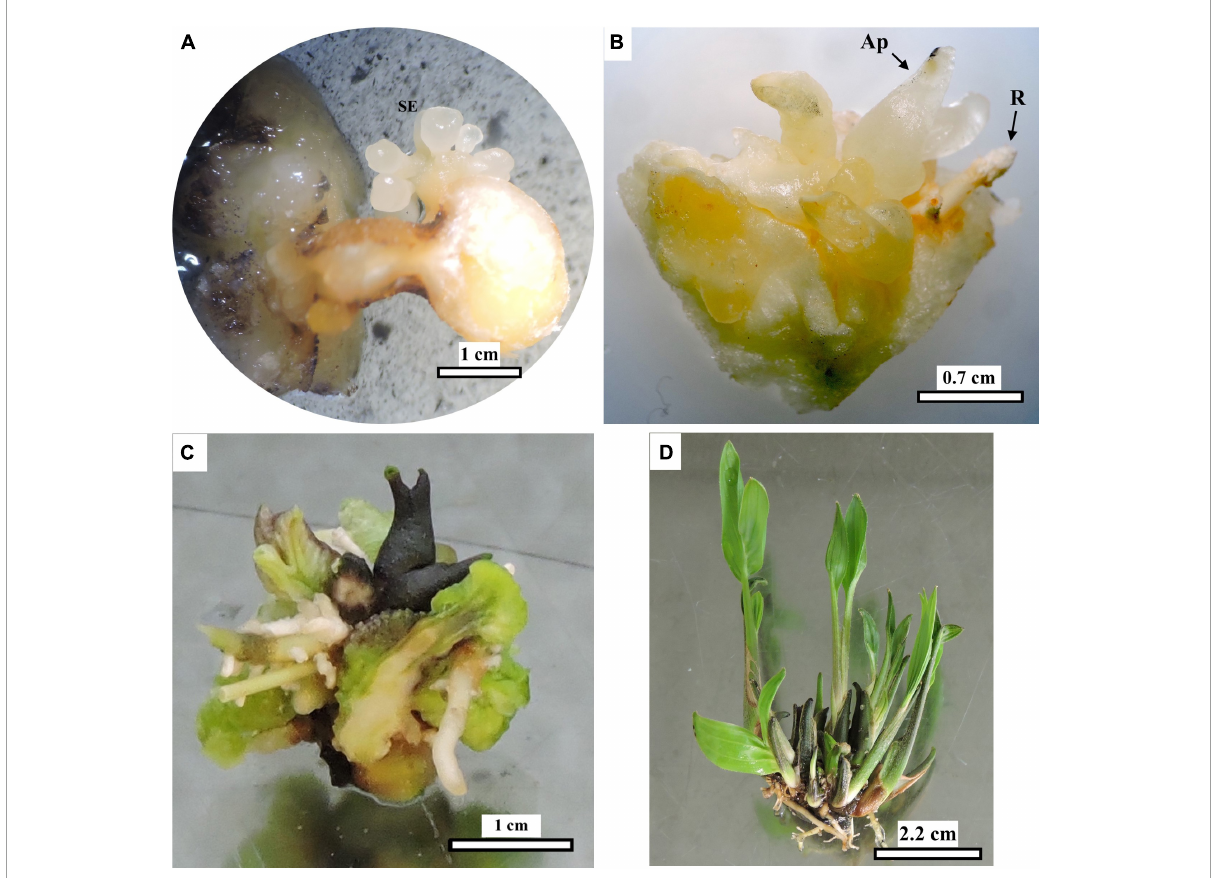
FIGURE8 Development and conversion of peach palm somatic embryos into plantlets. Elongated and mature embryos after subculture in the “Development” medium (A) , which later developed shoot and root apices when subcultured to “Conversion” medium (B) . Explant with shoot and root clusters after transfer to medium devoid of plant growth regulators and to light conditions (C) . Rooted plantlet clump after division of larger clump (D) . Ap: apical shoot, R root. Black bars scale equivalent to 1 cm (A) , 0.7 cm (B) , 1 cm (C), and 2.2 cm (D) .